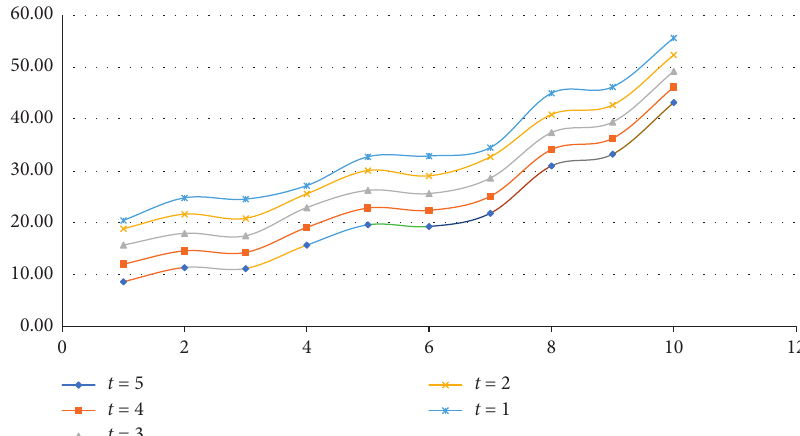
Figure 7: c � 1.3 and δ � 1. The difference of prospect value between the drone and the